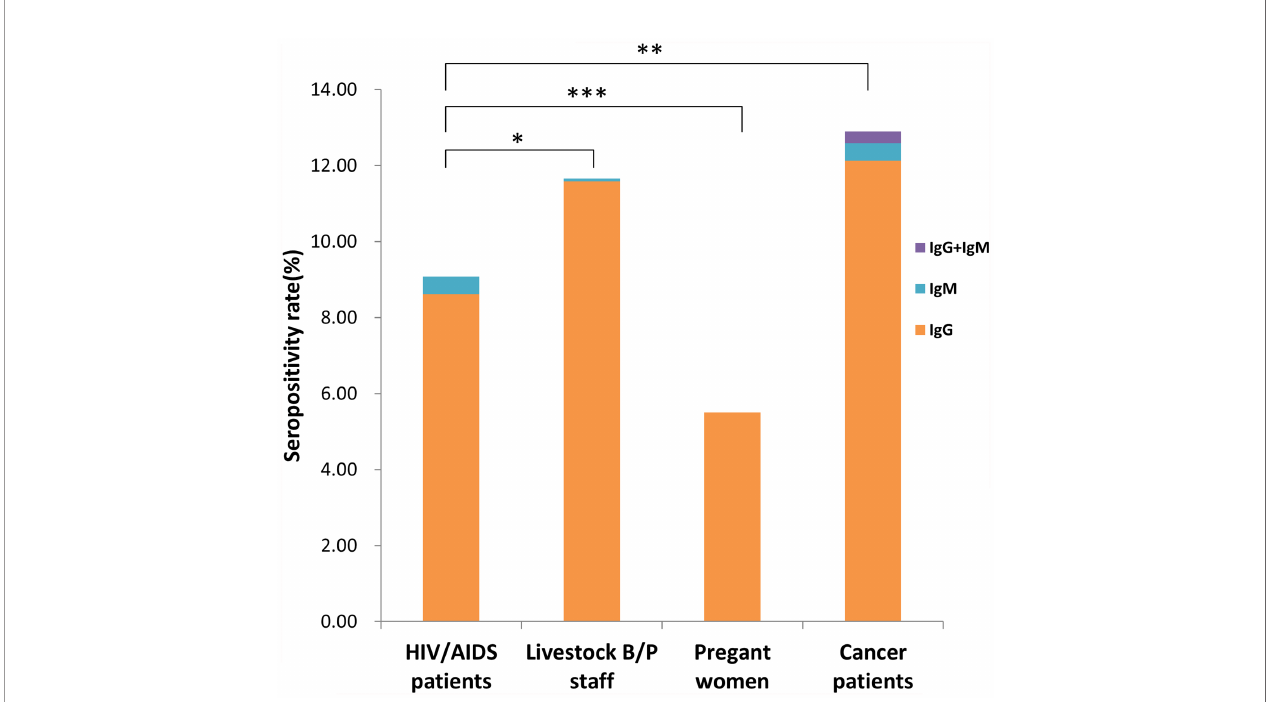
FIGURE 1 | Seropositivity rate for different high-risk populations in Jiangsu Province, China. (* P < 0.05, ** P < 0.01, *** P <